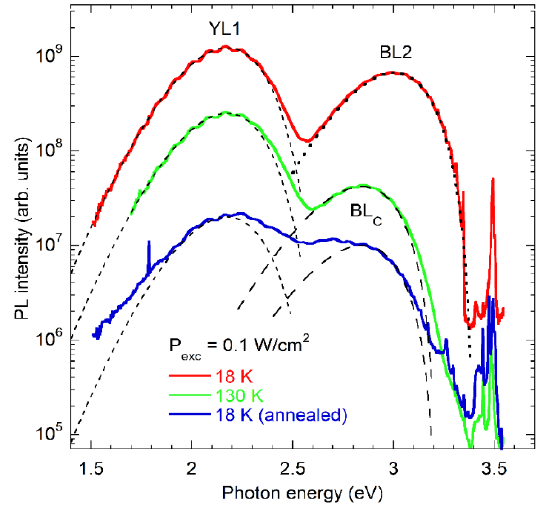
Figure 1. PL spectra at 18 and 130 K for as-grown GaN:C and at 18 K after annealing at T ann = 800 ◦ C. The BL2 band is completely quenched at 130 K, revealing the BL C band. In the annealed sample, the BL2 band is not found even at 18 K. The dashed lines are calculated using Equation (1) with the following parameters: S e = 7.7, E ∗ = 2.67 eV and d g FC = 0.50 eV (YL1 band); S e = 4.4, E ∗ = 3.38 eV and d g FC = 0.38 eV (BL2 band); and S e = 3.5, E ∗ = 3.2 eV and d g FC = 0.35 eV (BL C band). ∆ = 0.01 eV. A sharp line at 1.79 eV is caused by an internal transition in Cr 3+ ions in the sapphire substrate, which becomes noticeable when the PL signal from GaN is weak.